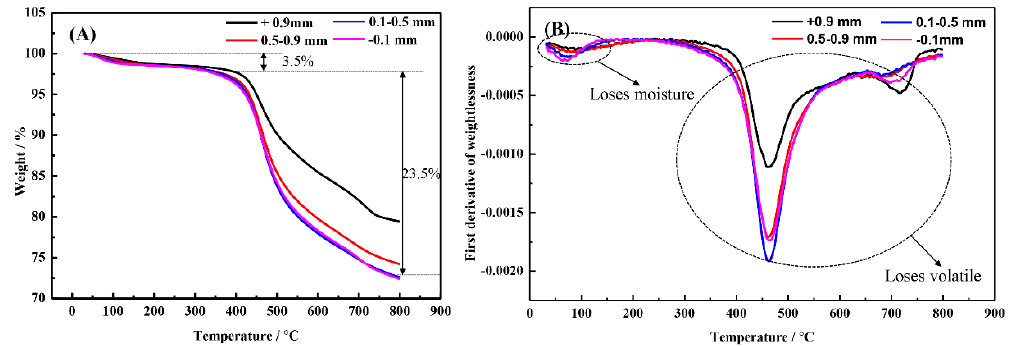
Figure 4. Thermogravimetric characteristic curves of raw coal with different particle sizes. ( A ) thermogravimetric curves; and ( B ) derivative thermogravimetric curve.